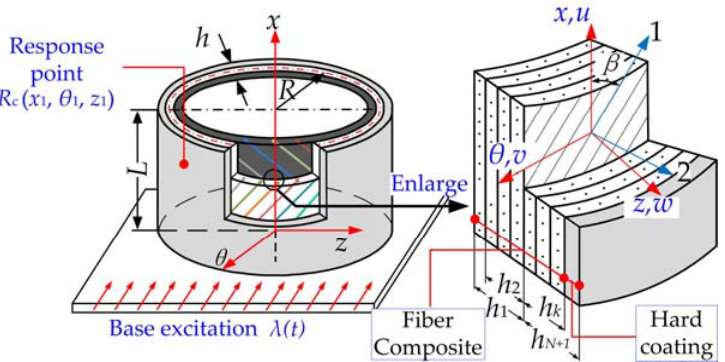
Figure 1. The theoretical model of fiber ‐ reinforced composite thin shell (FCTS) with hard coating.